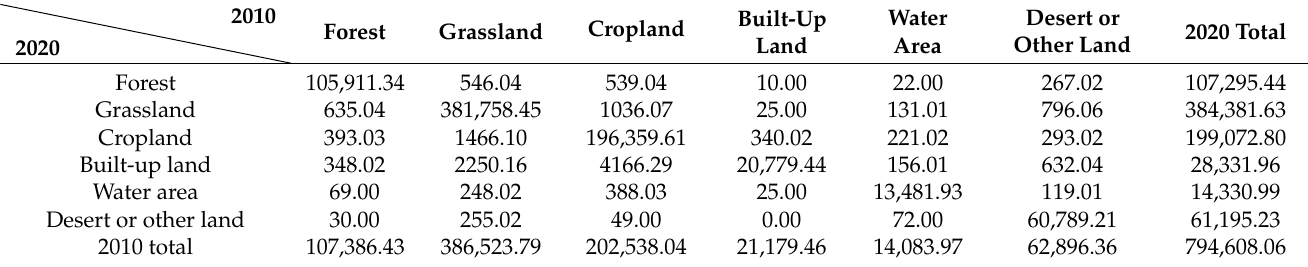
Table 5. Transformed areas of each land cover type in YRB between 2010 and 2020 (unit: km 2